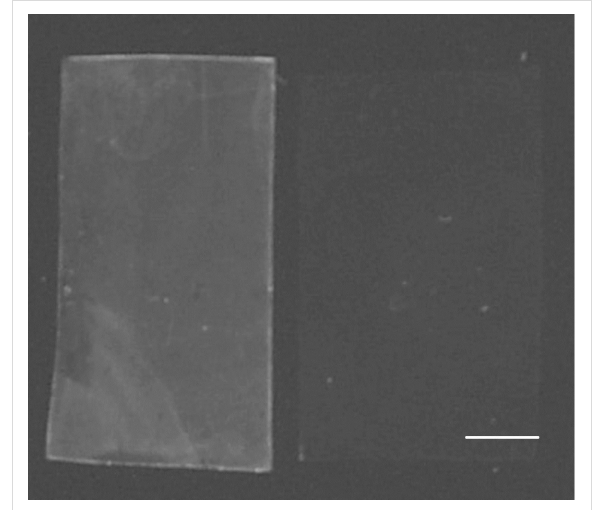
Figure 2: Analyses of functionalized TPX membranes with UV light at 312 nm; left: derivative 4 ; right: nonfunctionalized material as negative control (scale bar equals 1